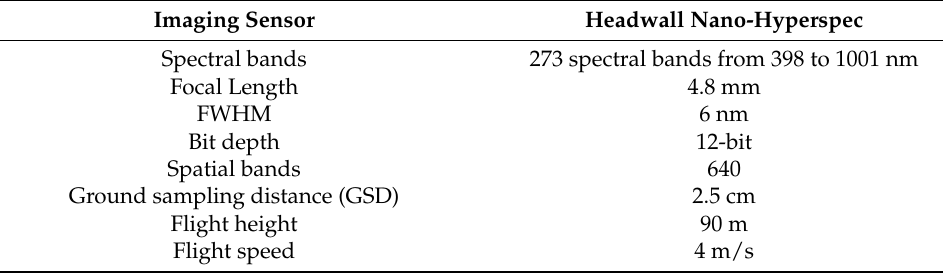
Table 1. Camera and flight characteristics of the equipment used in the